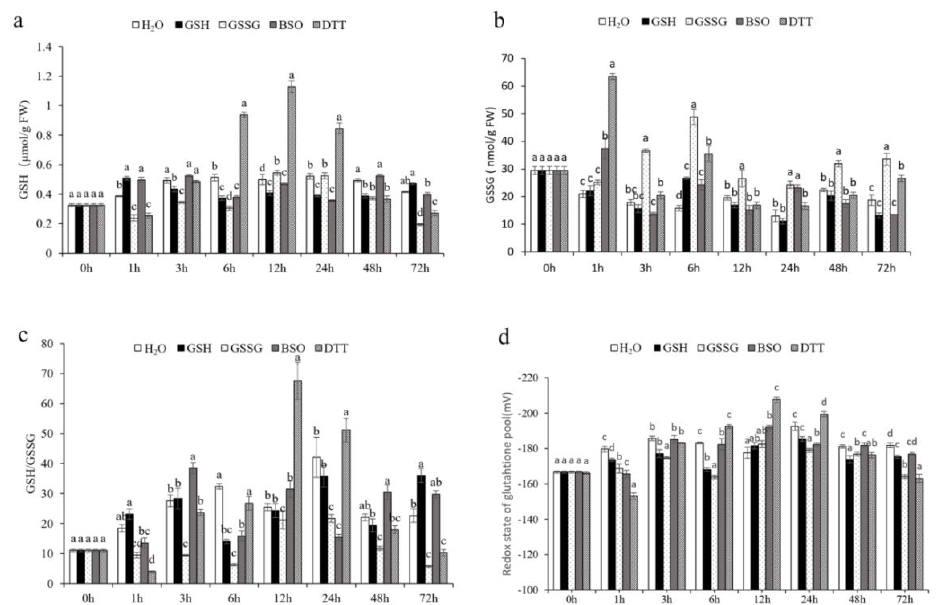
Figure 5. Content of GSH metabolism in leaves of pakchoi ( Brassicarapa L. ssp. chinensis ) plants treated with GSH (100 μM) or GSSG (100 μM) or BSO (1 mM) or DTT (5 mM). ( a ) Reduced glutathione (GSH). ( b ) Oxidized glutathione (GSSG). ( c ) Molar ratio of GSH/GSSG. ( d ) Redox state of the glutathione pool. Data are the means of three biological replicates (±SD) shown by vertical error bars. Different letters indicate significant differences according to Tukey’s test at 0.05% level.